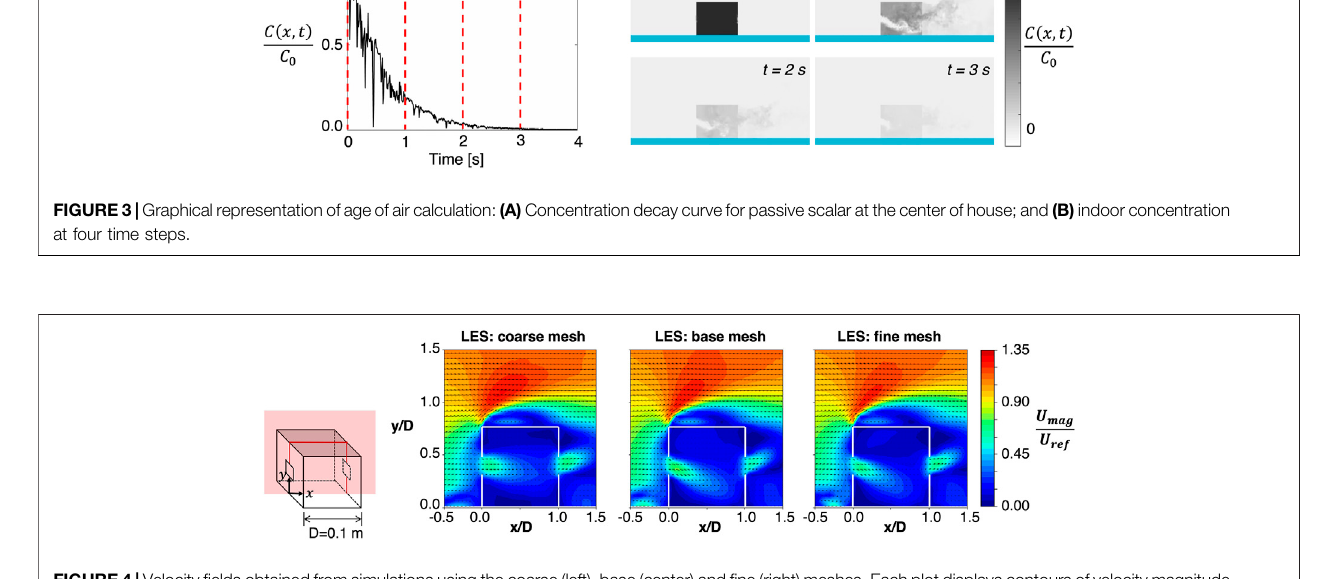
FIGURE4| Velocity fi eldsobtainedfromsimulationsusing thecoarse (left),base(center) and fi ne(right)meshes. Eachplotdisplayscontoursofvelocity magnitude contours together with a quiver plot to visualize the fl ow direction.